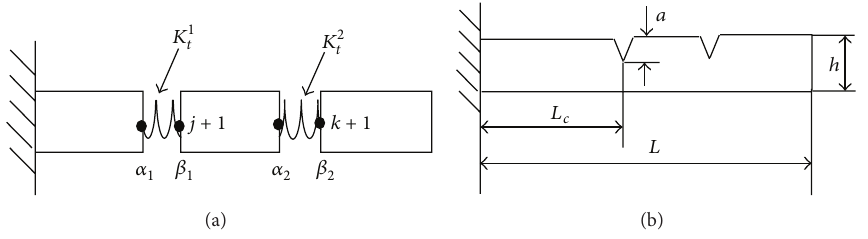
Figure 1: Cracked cantilever beam: (a) geometry, (b) model of cracked